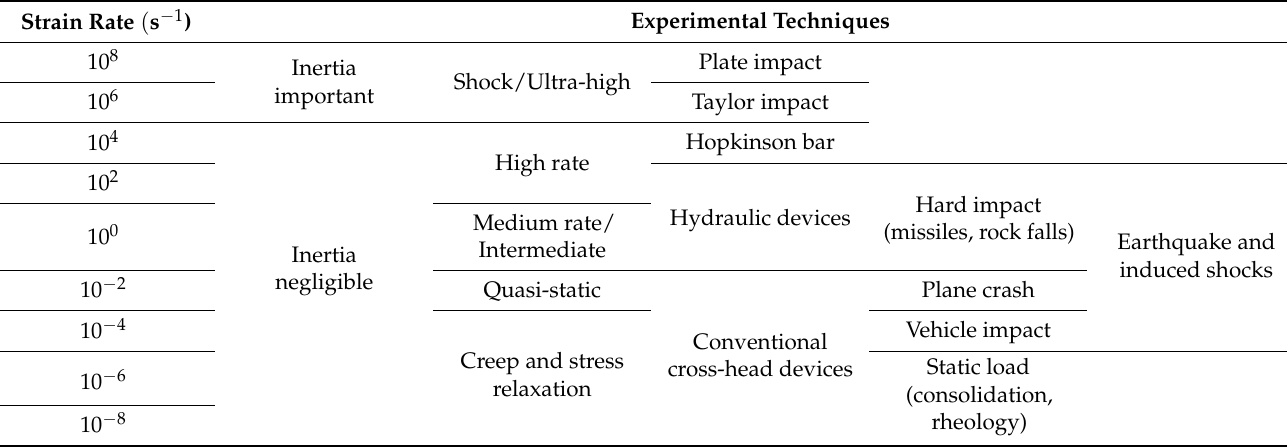
Table 1. List of ranges of strain rate and experimental